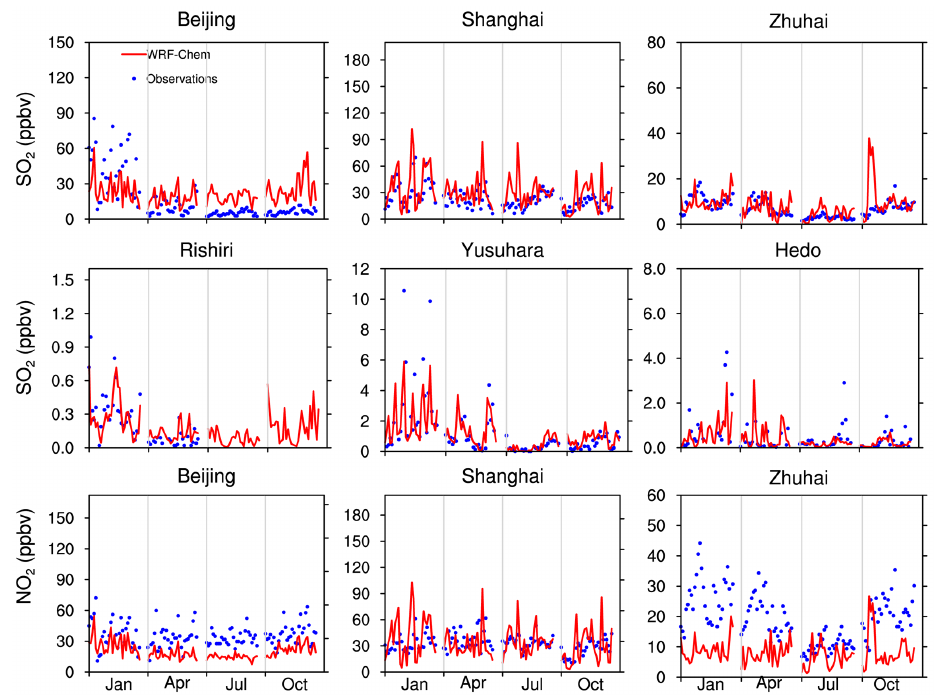
Figure 11. Comparisons of observed (blue dots) and modeled (red lines) daily mean SO 2 (ppbv) at six sites in China and Japan and NO 2 (ppbv) at three sites in